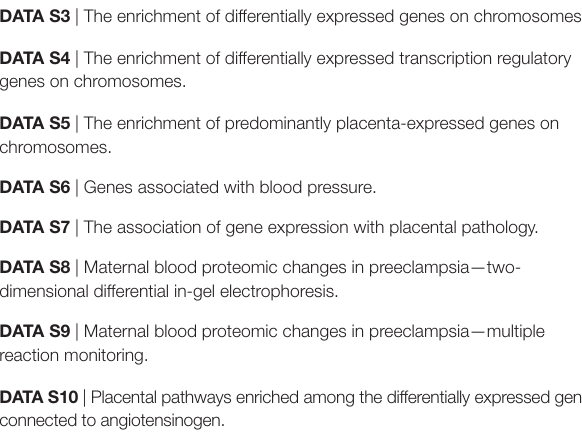
progenitor. Lower three lanes: bisulfite sequencing data in this study. Abbreviations: CB, cord blood cell; CT, cytotrophoblast; ST, syncytiotrophoblast. Red box: differentially methylated region; red arrow: CpG Chr3:187458163. FigUre s9 | DNA methylation levels at individual CpGs in BCL6 in the trophoblast and umbilical cord blood cells. DNA methylation levels (0–100%) at individual CpGs in BCL6 in umbilical cord blood cells (CB), cytotrophoblasts (CT), and differentiated syncytiotrophoblasts (ST) are depicted in the bar plots that represent means and SEs. Umbilical cord blood cells and cytotrophoblasts were obtained from the same fetuses. The genomic coordinates of the CpGs, the group differences (CB vs. CT; CT vs. ST) in mean DNA methylation levels and the p -values are shown above the bar plots. The number of samples analyzed with